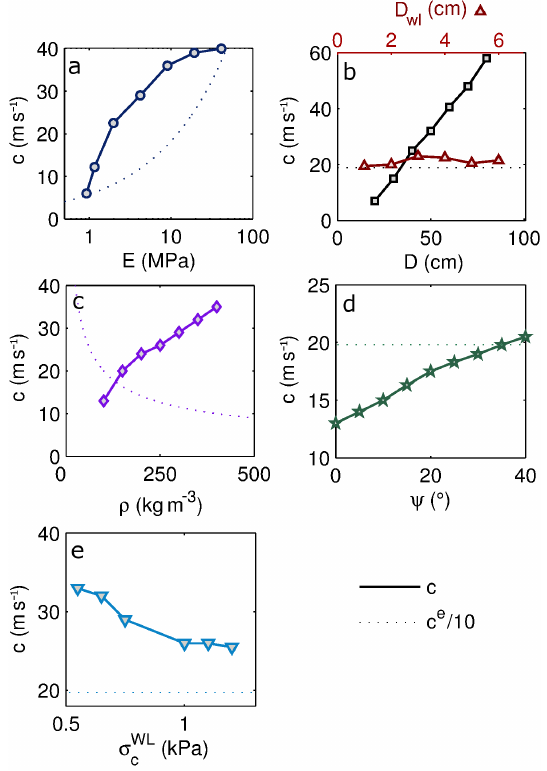
Figure 10. Crack propagation speed c (continuous lines) and speed of elastic waves in the slab c e / 10 (dotted lines) as a function of (a) the Young’s modulus of the slab E , (b) slab thickness D and WL thickness D wl , (c) slab density ρ , (d) slope angle ψ and (e) WL compressive strength σ WL c . The parameters used for these figures are given in Table